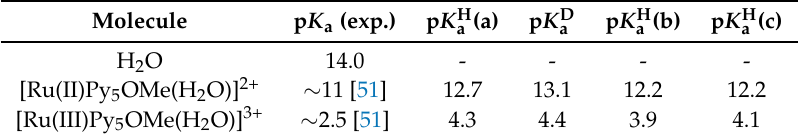
Table 5. All results presented here are calculated at 320 K, for a cubic box with a side length of 19.7340 Å, over a trajectory of about 20 ps (where the first 5 ps were not included in the evaluation). The p K a values were calculated using the probabilistic method for a R c value of 1.25 Å determined for D 2 O. The p K H a (a) was obtained referencing the calculations to H 2 O i.e., a R c of 1.24 Å. The p K D a values were converted to p K H a values according to Equation 10 (b), respectively Equation (13) (c).